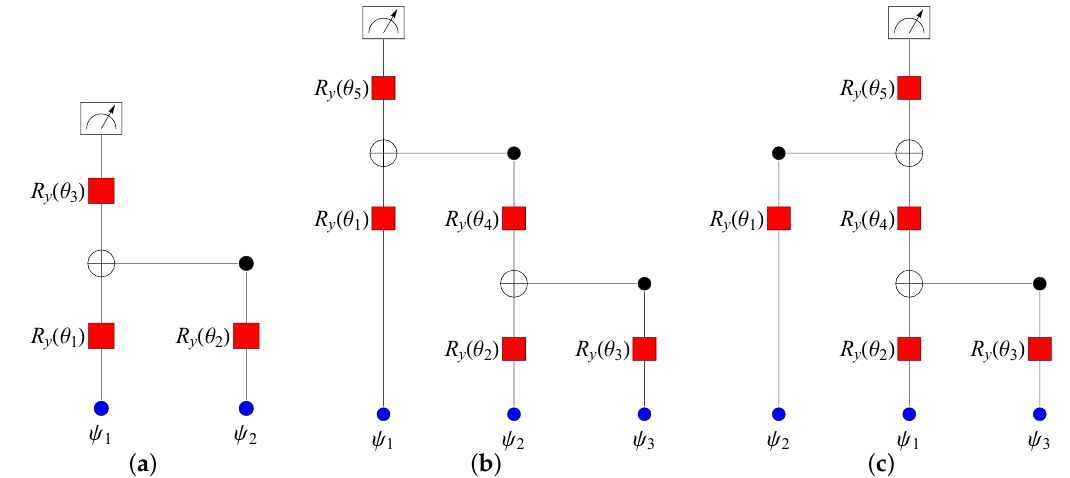
Figure 3. Feature selection circuits scheme, where lines not further elaborated are omitted. The two-qubit case is represented in panel ( a ), while two non-equivalent three-qubit circuits are shown in panels ( b , c